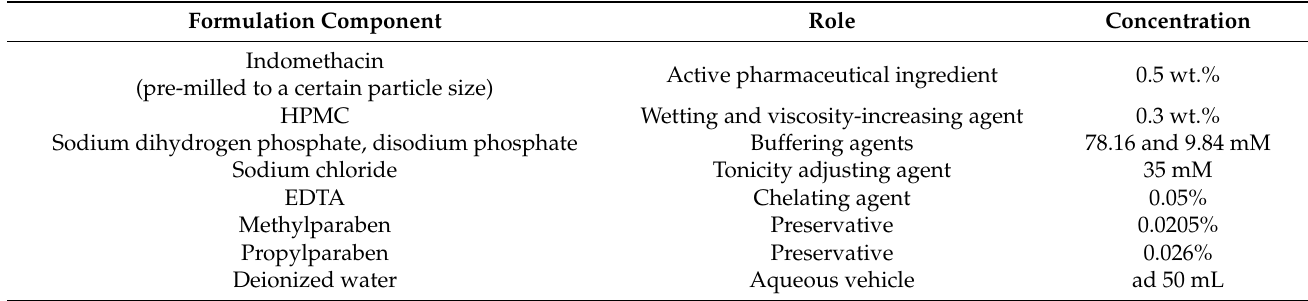
Table 2. Indomethacin test